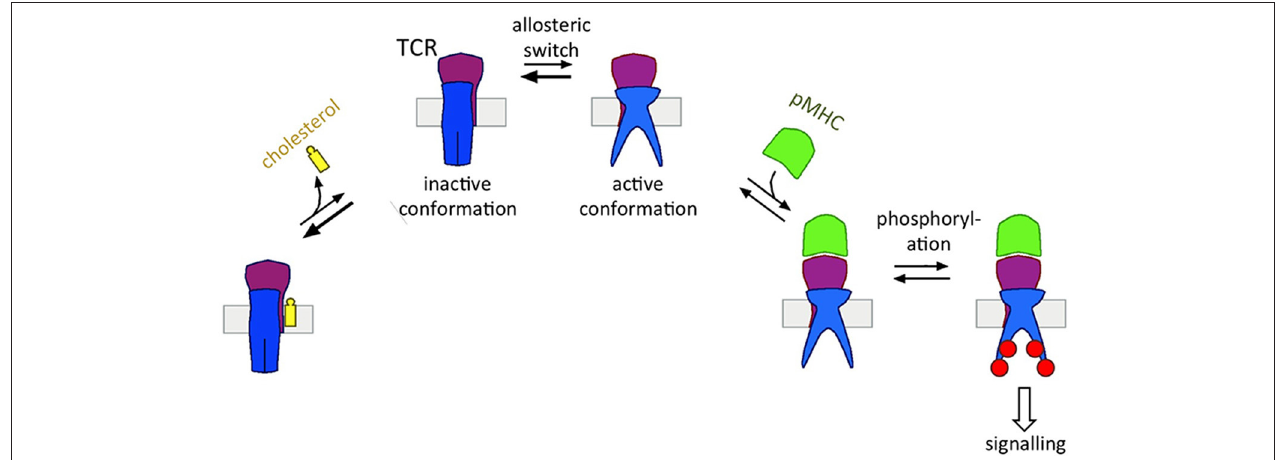
FIGURE 2 | Cholesterol’s function of regulating the allosteric switch of the TCR. The TCR can switch spontaneously between the inactive and active state (allosteric switch). Cholesterol binds to the TCR β subunit only in the inactive TCR, thus shifting the equilibrium to the left side. The pMHC ligand binds to the TCR α β subunits only in the active TCR, thus shifting the equilibrium to the right side. Only in the active state the TCR can be phosphorylated transmitting the signal of pMHC-binding